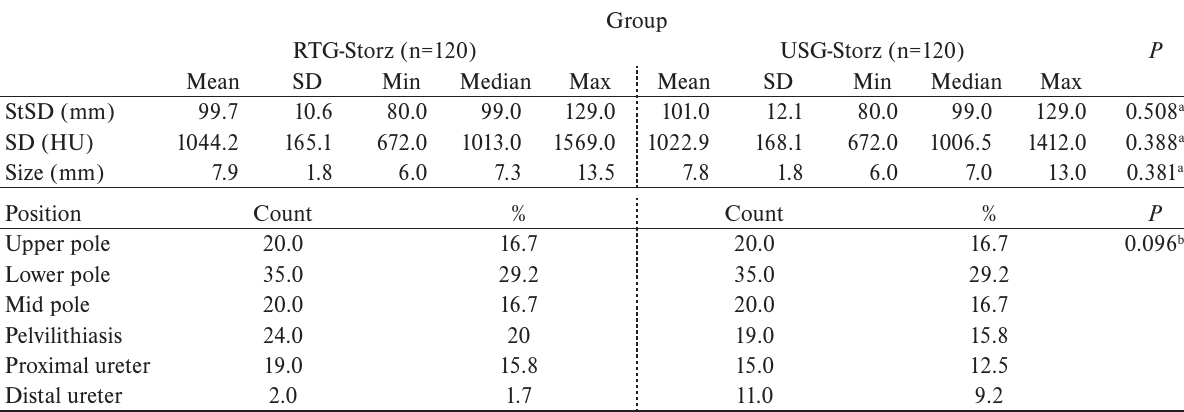
Table 1. Group characteristics.